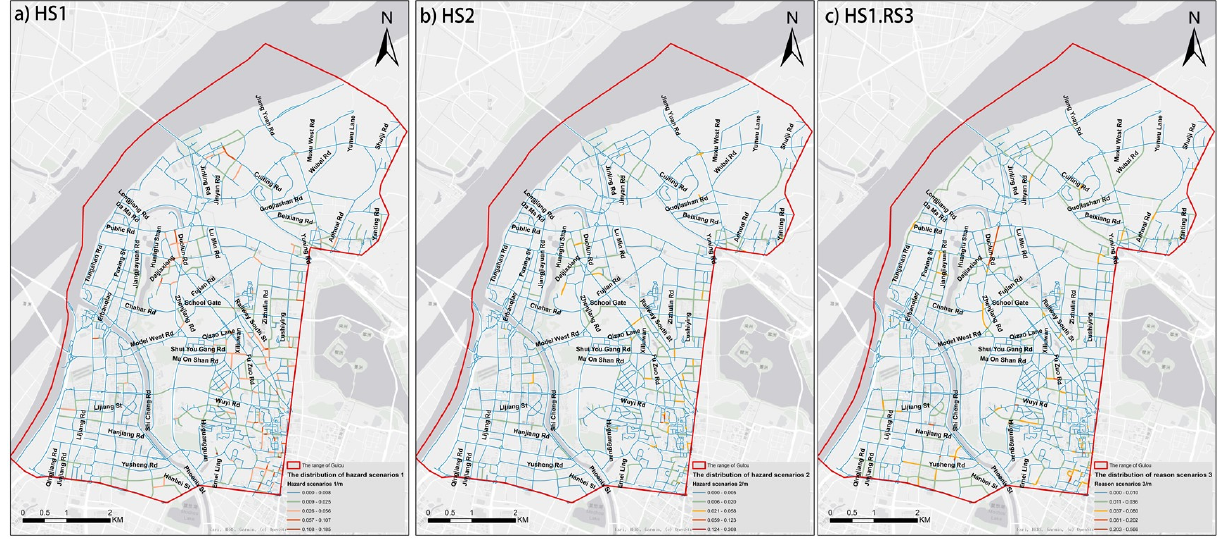
Figure 15. The occurrence frequencies of various types of scenarios in each road.